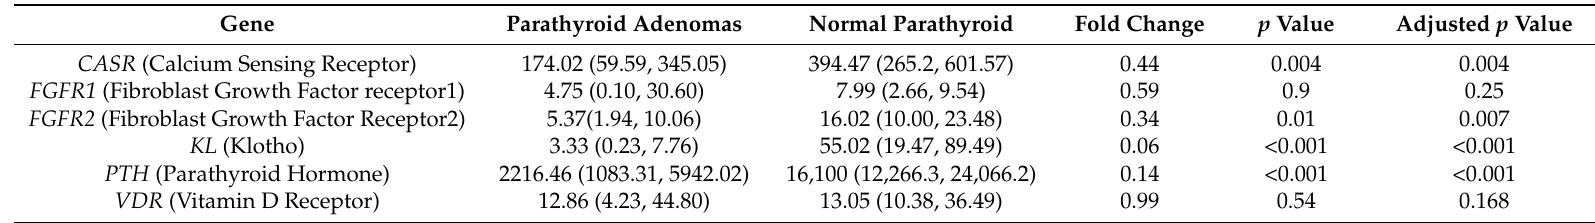
Table 3. mRNA expression levels of selected genes with parathyroid-related functions in parathyroid adenomas and parathyroid tissues. Gene CASR (Calcium Sensing Receptor) FGFR1 (Fibroblast Growth Factor receptor1) FGFR2 (Fibroblast Growth Factor Receptor2)